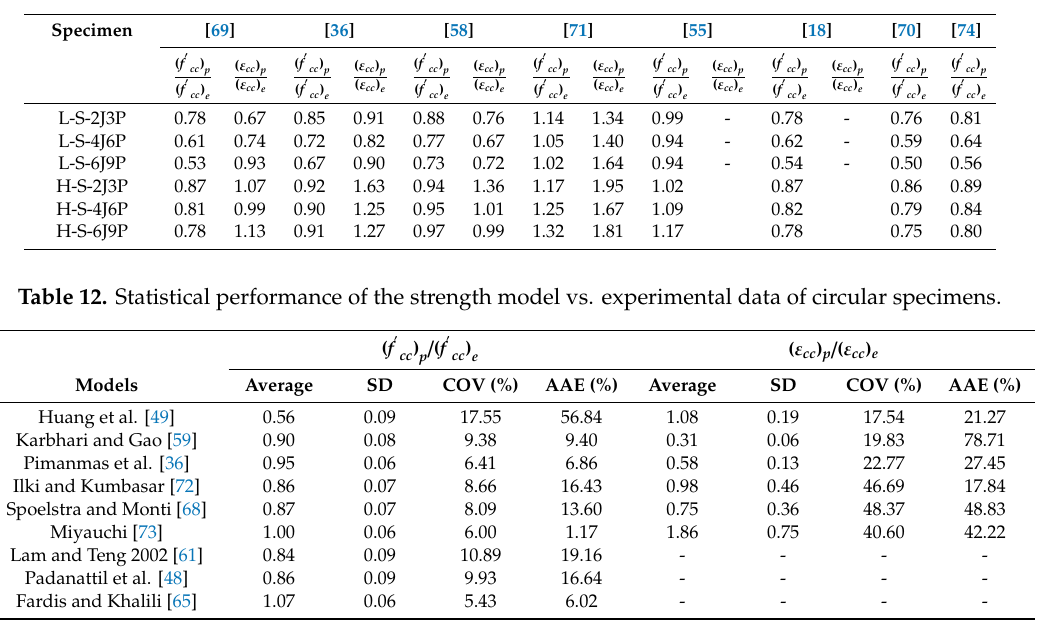
Table 11. Comparison of model predictions with experimental results of square specimens. Specimen